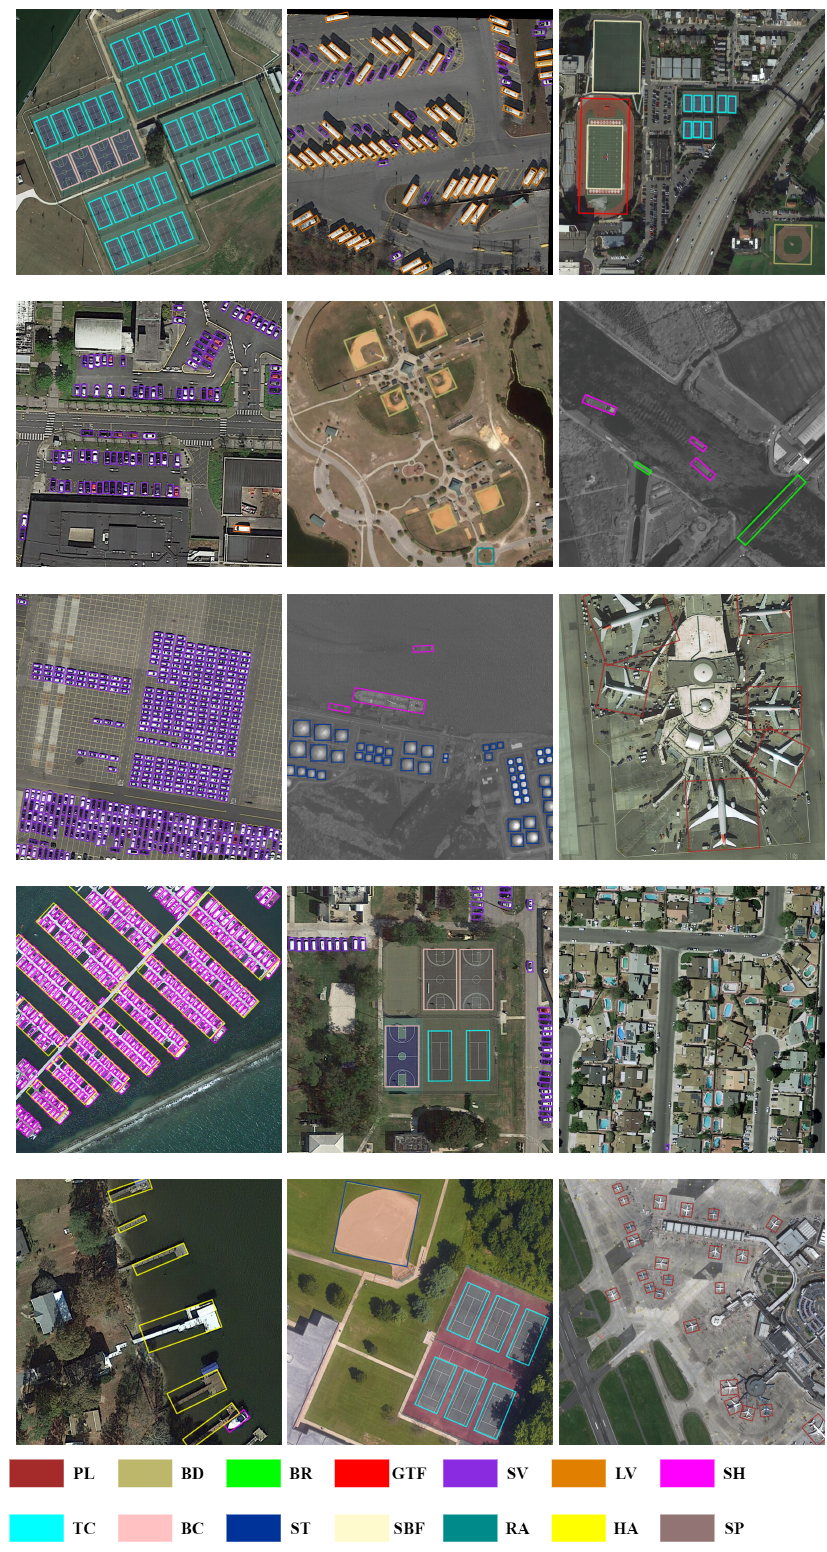
Figure 8. Visualization of predictions on the DOTA dataset using our method